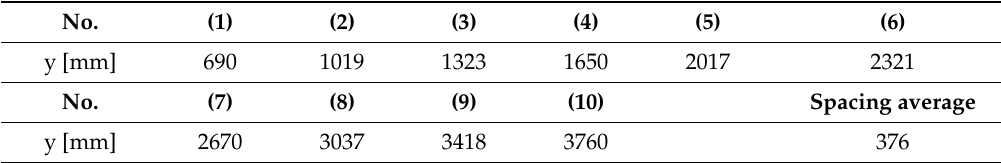
Table 6. Positions of 10 pieces on panel block (b).